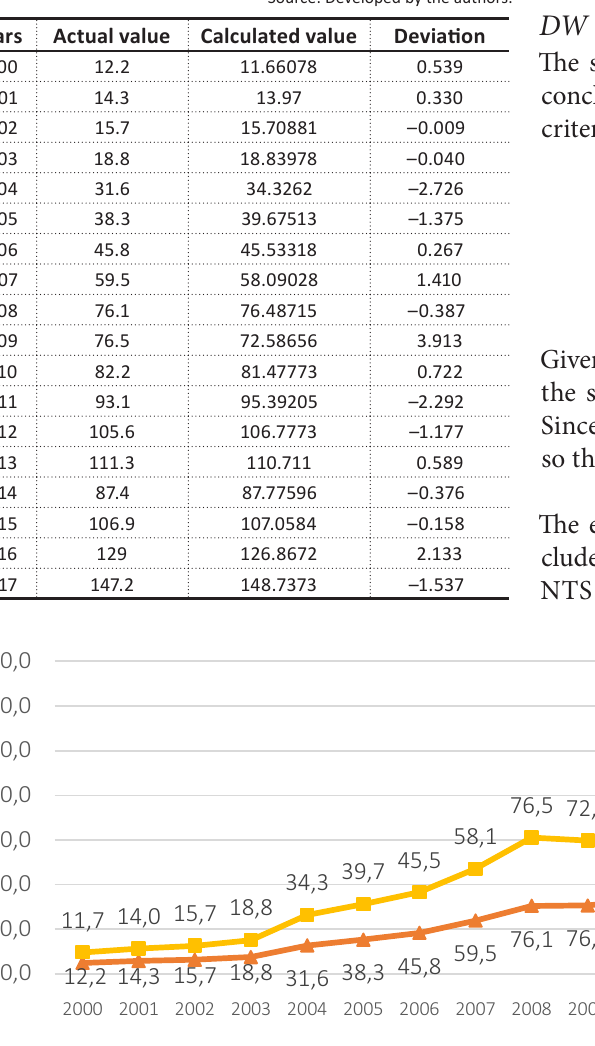
Table 1. Verification of the model constructed Source: Developed by the authors.